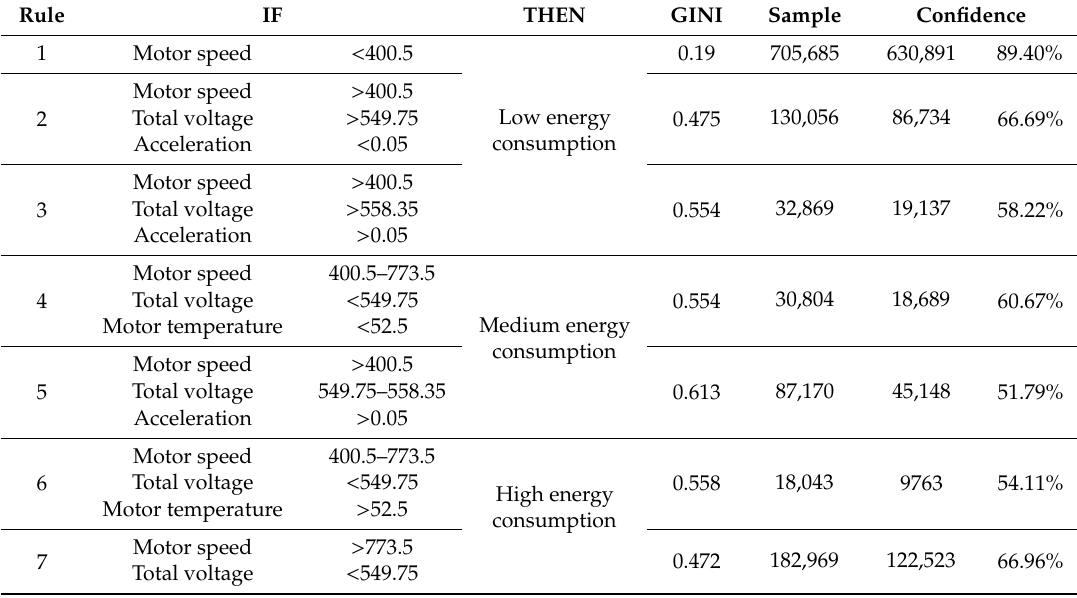
Table 12. Classification rules of route 355 in the case study.